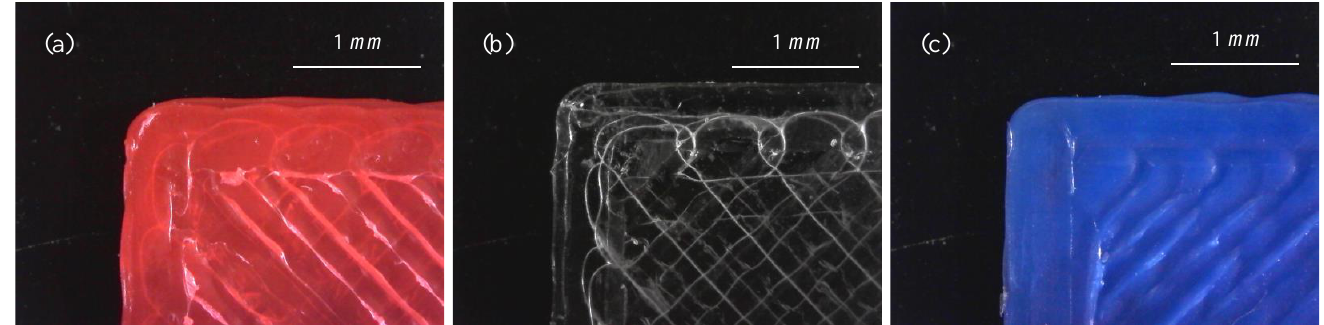
Figure 14. Example corners for printed samples of ( a ) ABS, ( b ) PC, and ( c )